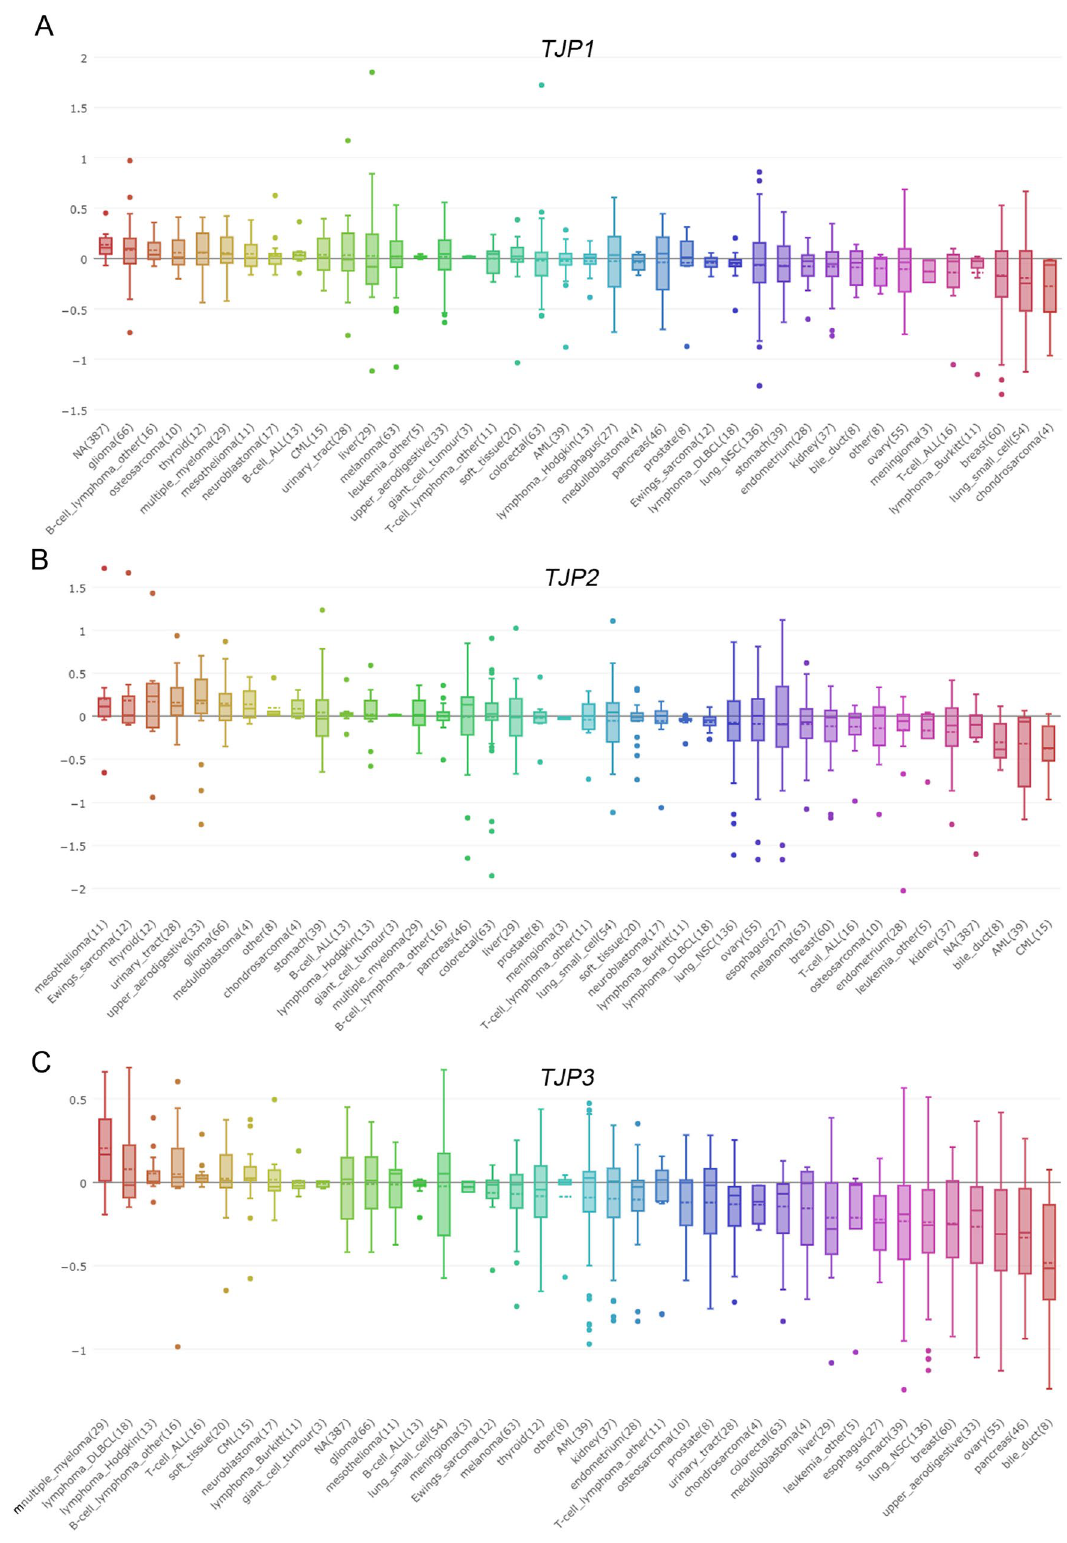
Figure 2. TJP1 DNA copy number in multiple cancer cell lines. Relative TJP1 ( A ), TJP2 ( B ) and TJP3 ( C ) DNA copy number in multiple cancer cell lines (CCLE dataset). The number of parentheses that how many cell have in the same cancer